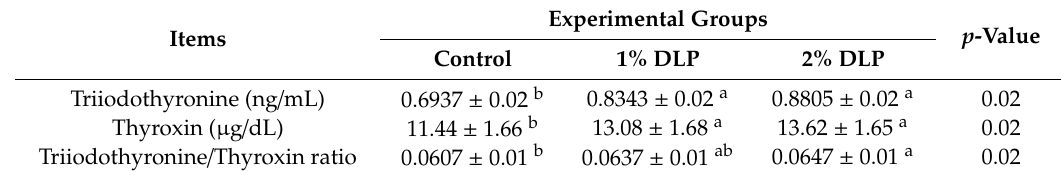
Table 7. E ff ects of dried lemon diet on thyroid hormones of growing